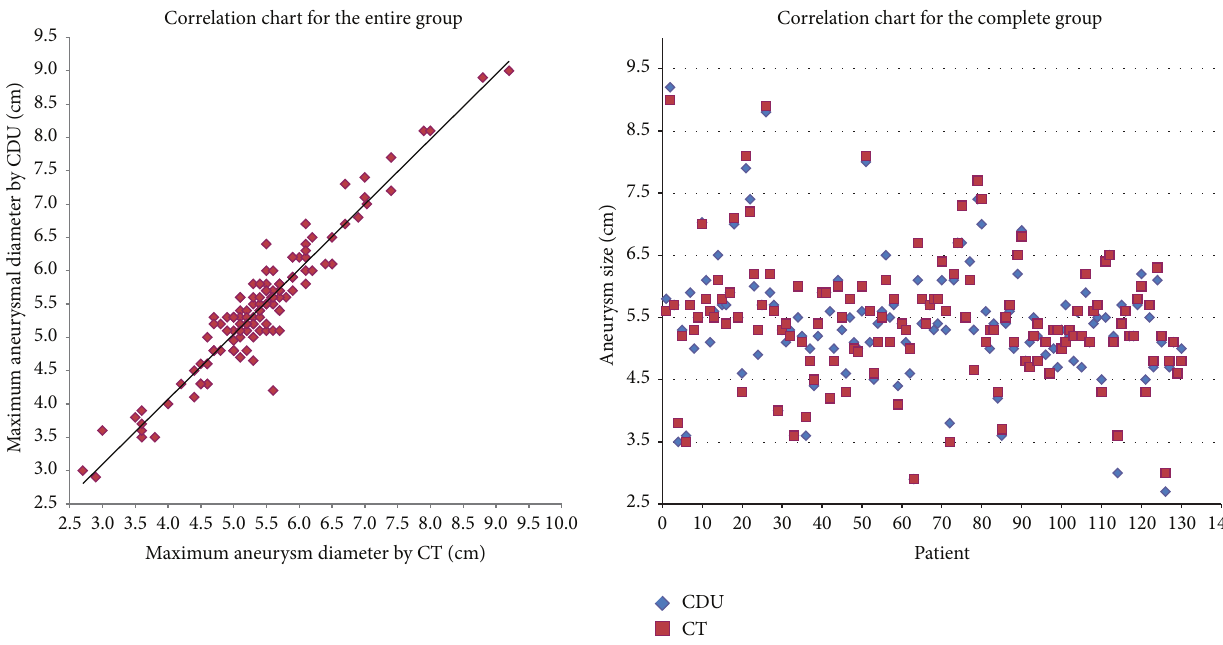
Figure 1: Correlation chart for the complete cohort showing a large degree of correlation between CDU and